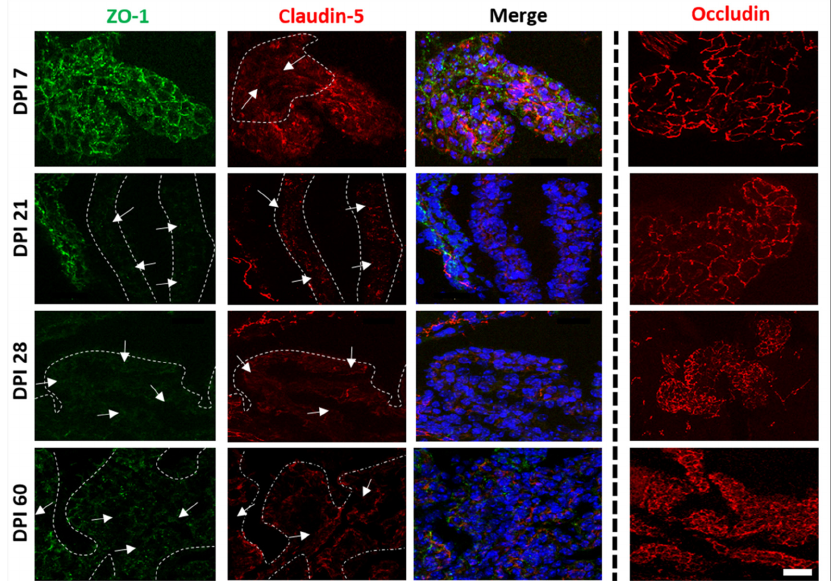
Figure 7. Temporal course of fluorescence immunolabeling for cell junctions in choroid plexus of mice infected with M. tuberculosis N15 (LAM 3) at different DPI. Arrows and dotted lines correspond to areas devoid of junctional proteins. The scale bar = 20 μ m is common for all micrographs.